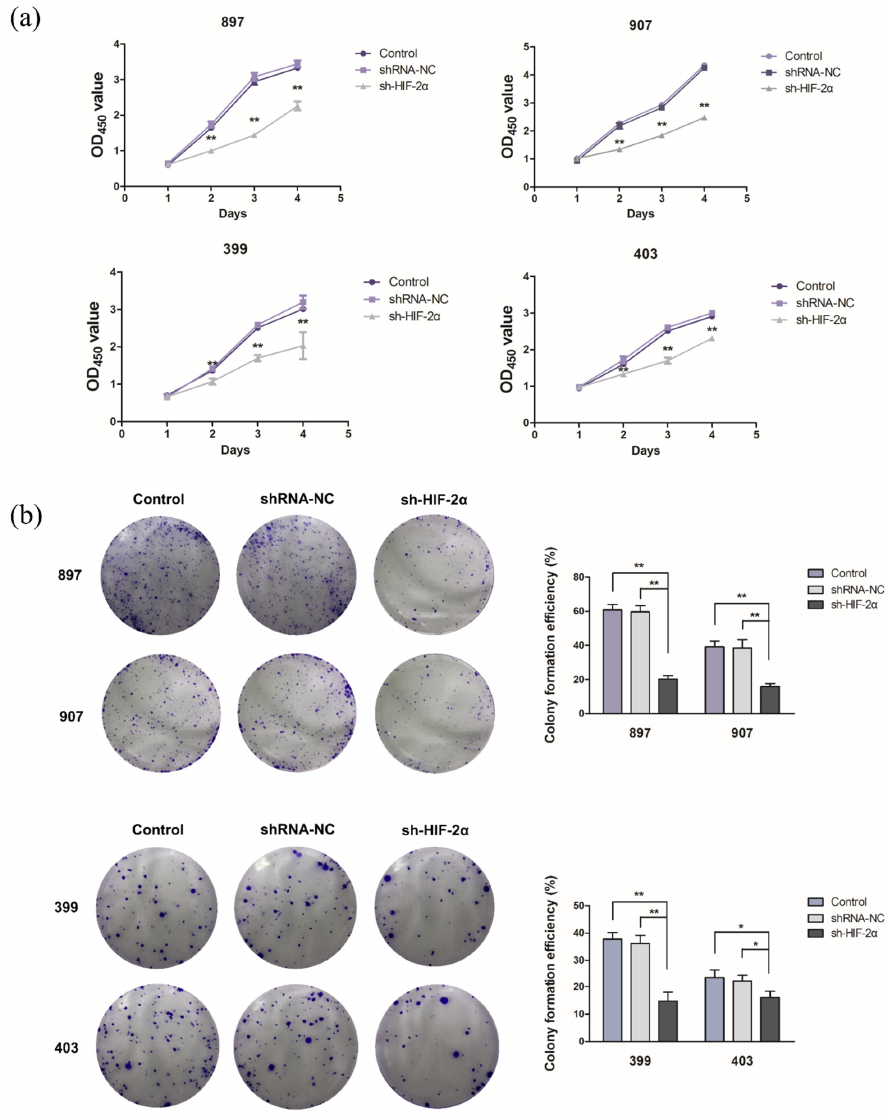
Figure 4. HIF-2 α knockdown inhibits the proliferation of Kras G12D and Kras G12D -LOH PDAC cells. Kras G12D and Kras G12D -LOH PDAC cells were transfected with sh-HIF-2 α and shRNA-NC. ( a ) Cell viability according to CCK-8 assay. ( b ) Cell proliferation measured by colony formation assay. Data are expressed as the mean ± SD, based on three independent experiments. * p < 0.05; ** p < 0.01.